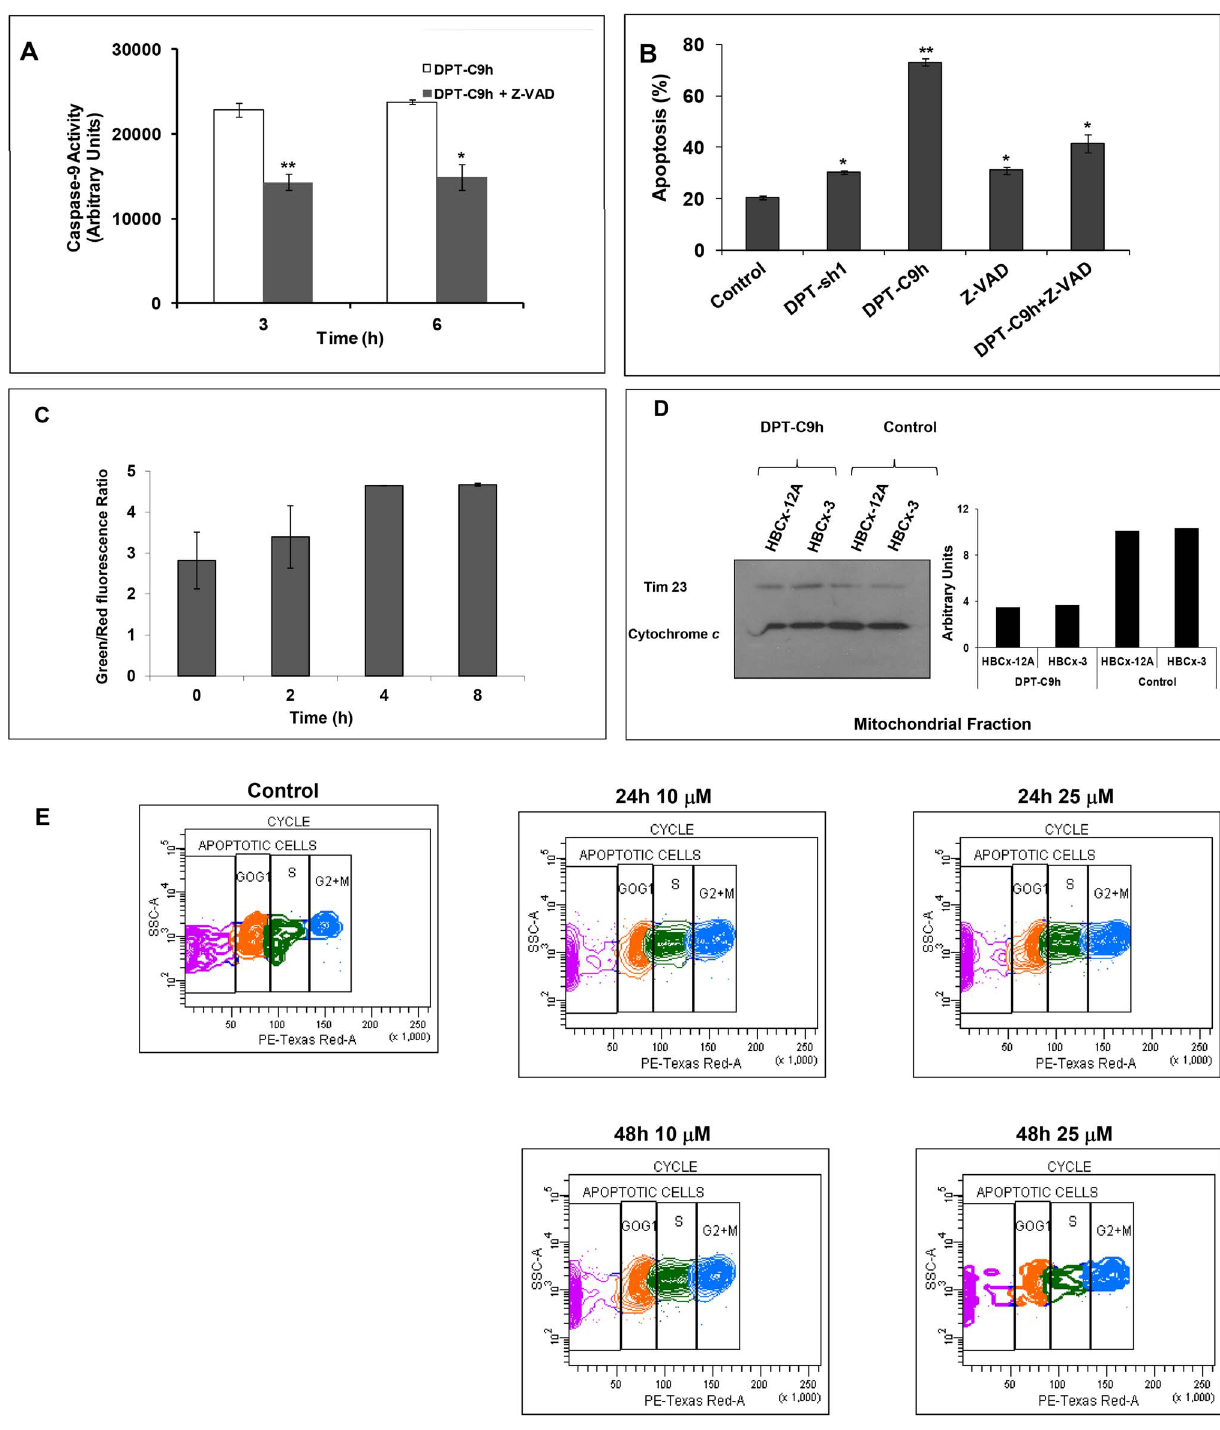
Figure 3. Effect of DPT-C9h on caspase-9 activation, mitochondrial membrane depolarization, cytochrome c release and cell cycle. A) HBCx-3 cells were cultured for 3 or 6 h with medium (control), 100 m M of DPT-C9h or 10 m M of the caspase inhibitor Z-VAD (pre incubation of 1h) and 100 m M of DPT-C9h. Caspase-9 activity was estimated using a luminogenic substrate. Results are represented relative to control non-treated cells as arbitrary units. P values are shown. B) HBCx-3 cells were cultured for 24 h with medium (control), DPT-Sh1 (100 m M), DPT-C9h (100 m M) or Z-VAD (10 m M, pre incubation of 1h) and DPT-C9h (100 m M). Apoptosis was estimated by Annexin-V-FITC binding. C) HBCx-3 cells were treated for different periods of time with DPT-C9h (100 m M) and then incubated for 30 min at 37 u C protected from the light with the fluorescent probe JC-10. Green and red fluorescence were measured. Data are represented relative to the control non-treated cells. P values are shown. D) HBCx-12A and HBCx-3 cell lines were treated for 24 h with 100 m M of DPT-C9 h. Mitochondrial fraction was separated from whole cell lysates and immunoblotted for cytochrome c . The WB was also hybridized with the mitochondrial marker Tim23 as internal control of protein loading. E) HBCx-3 cells were non- treated (control) or treated with 10 or 25 m M of DPT-C9h for 24 or 48 h and the cell cycle was analyzed by FACS. doi:10.1371/journal.pone.0060816.g003 PLOS ONE |